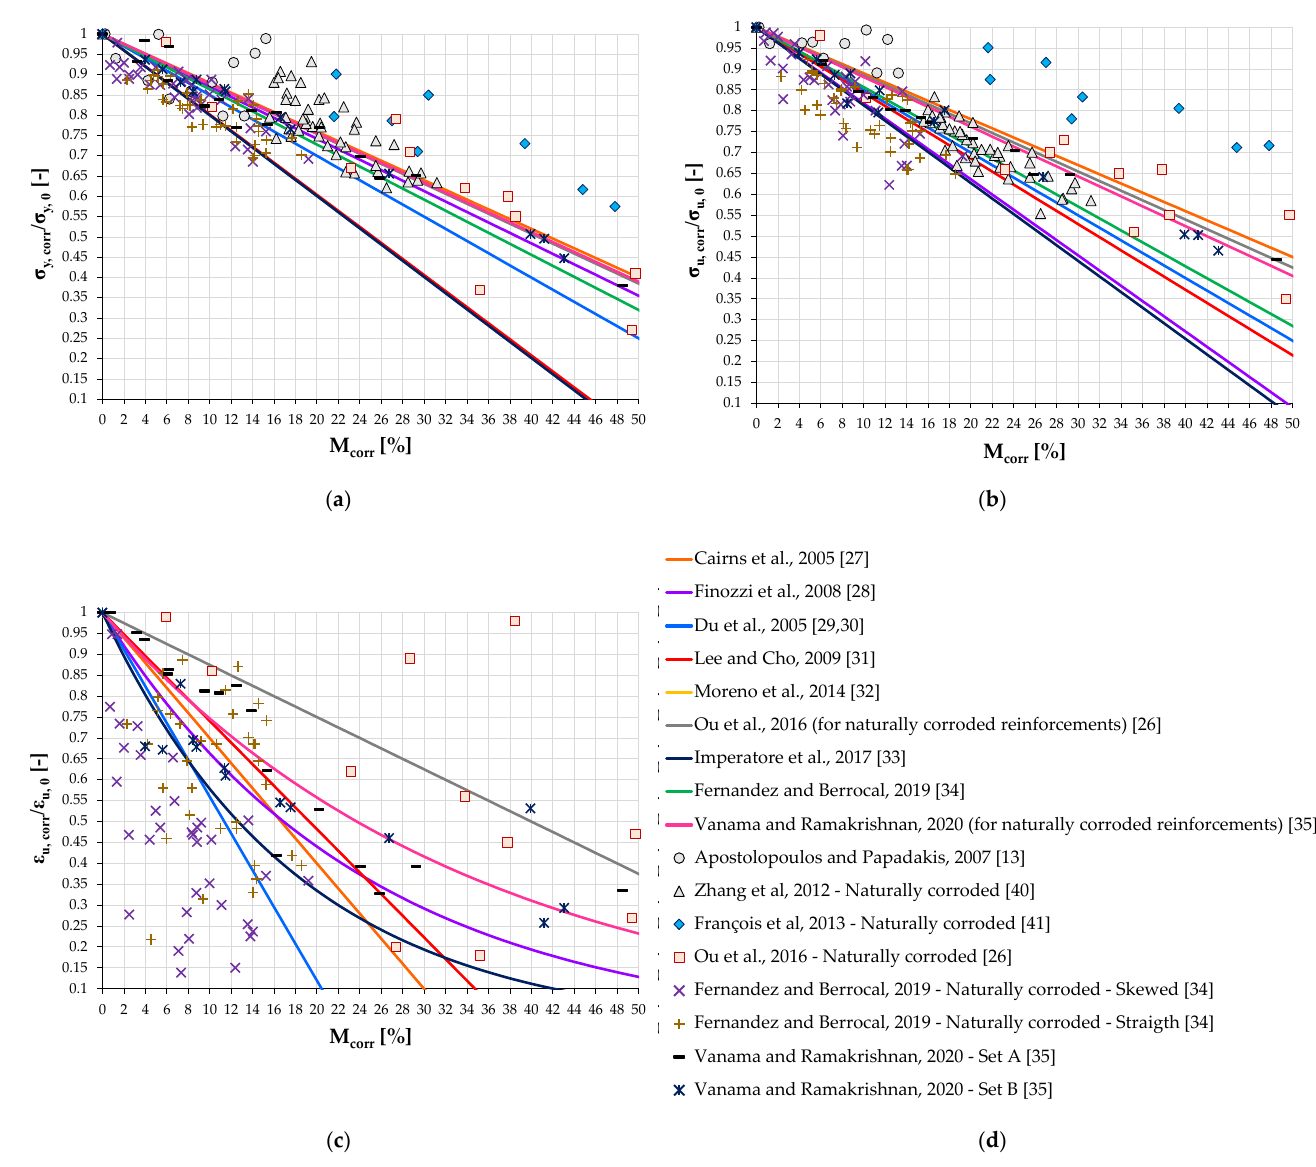
Figure 4. Comparison between the literature decay laws for pitting corrosion and the mechanical properties of naturally corroded rebars [13,26–35,40,41]: ( a ) yielding and ( b ) ultimate strength and ( c ) ultimate strain; ( d ) charts’